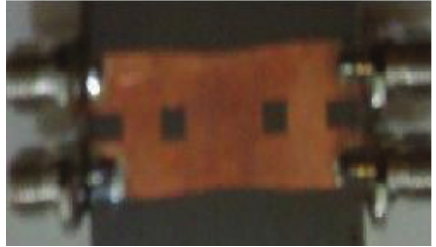
Figure 8: Photograph of microstrip nonuniform crossover.